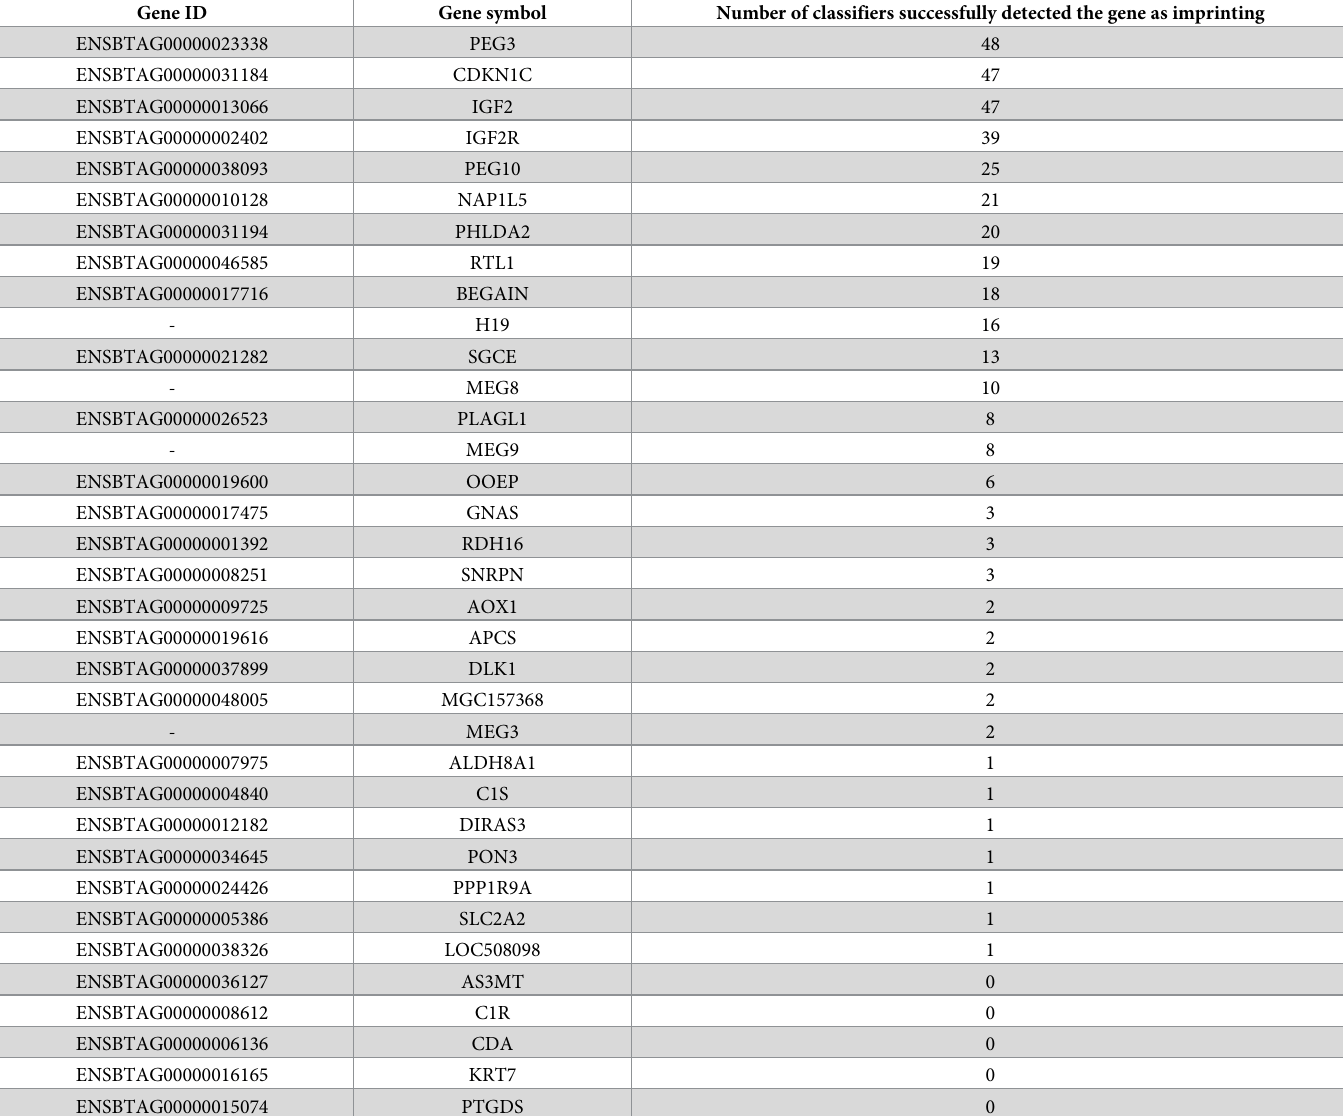
Table 6. Number of classifiers successfully detected the gene as imprinted. Gene ID Gene symbol Number of classifiers successfully detected the gene as